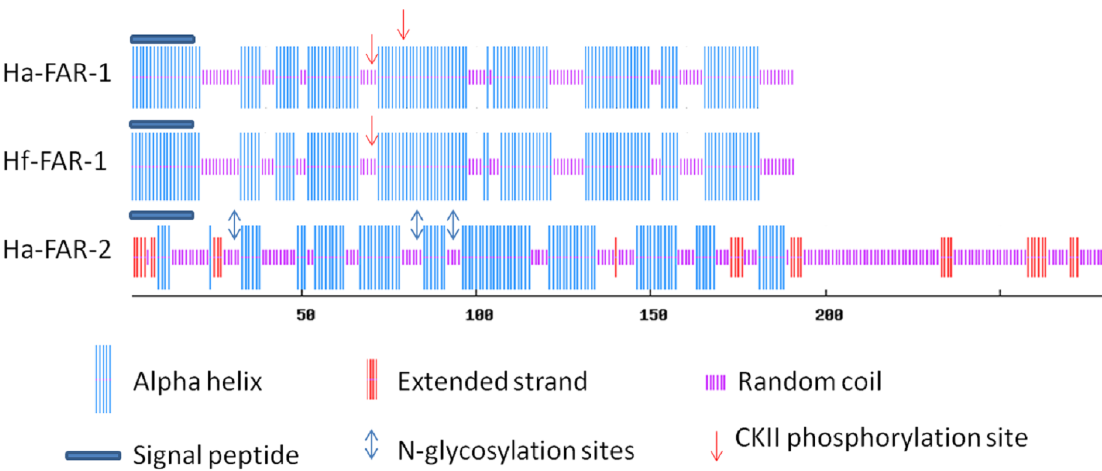
Fig 3. Secondary structure of cereal cyst nematode FAR proteins. Ha-FAR-1,Ha-FAR-2 and Hf-FAR-1 contained a putative signal peptide at the N terminus (long dark blue rod) and were rich in alpha helix (long vertical blue lines) and random coil (short vertical violet lines) structures. An extended strand (moderate vertical red lines) was detected in Ha-FAR-2. Ha-FAR-1 had two predicted casein kinase II phosphorylation sites at amino acids 71 and 81, and Hf-FAR-1 has one at amino acid 71 (red arrow). NetNGlyc 1.0 Server indicated that neither Ha-FAR-1 nor Hf-FAR-1 has a predicted N-glycosylation site but that Ha-FAR-2 contains predicted N-glycosylation sites (double sided blue arrows) at amino acids 32, 84 and 94.